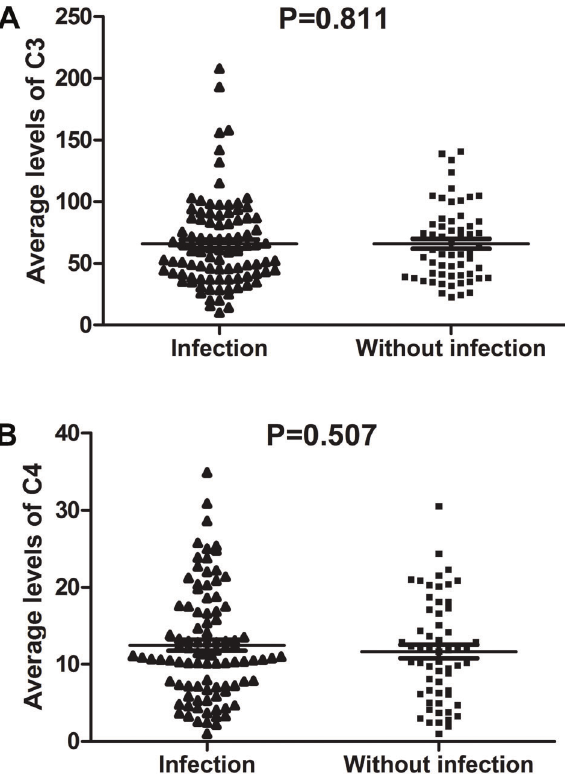
Figure 3. Complement C3 ( A ) and C4 ( B ) levels determined by nephelometry in the serum specimens of systemic lupus erythe- matosus patients with or without infection (Mann-Whitney U or